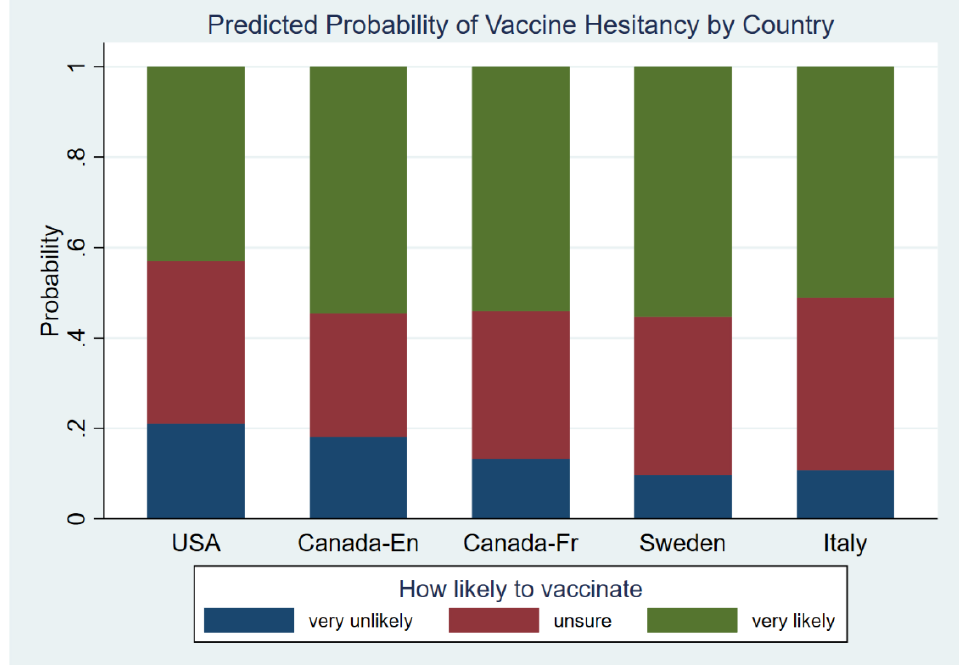
Figure 1. Predicted Probability of Vaccine Hesitancy by Country.